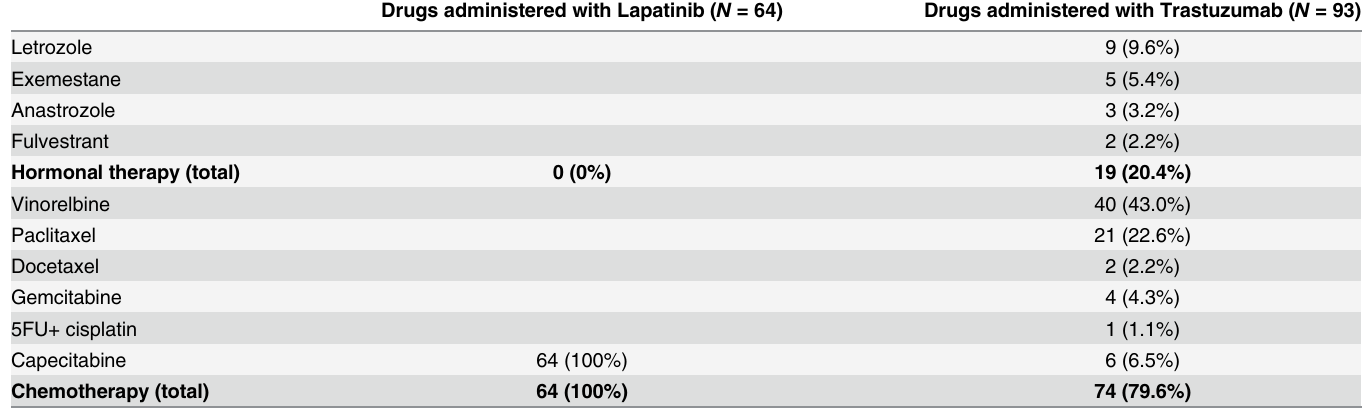
Table 2. Drugs administered in parallel with second-line anti Her-2